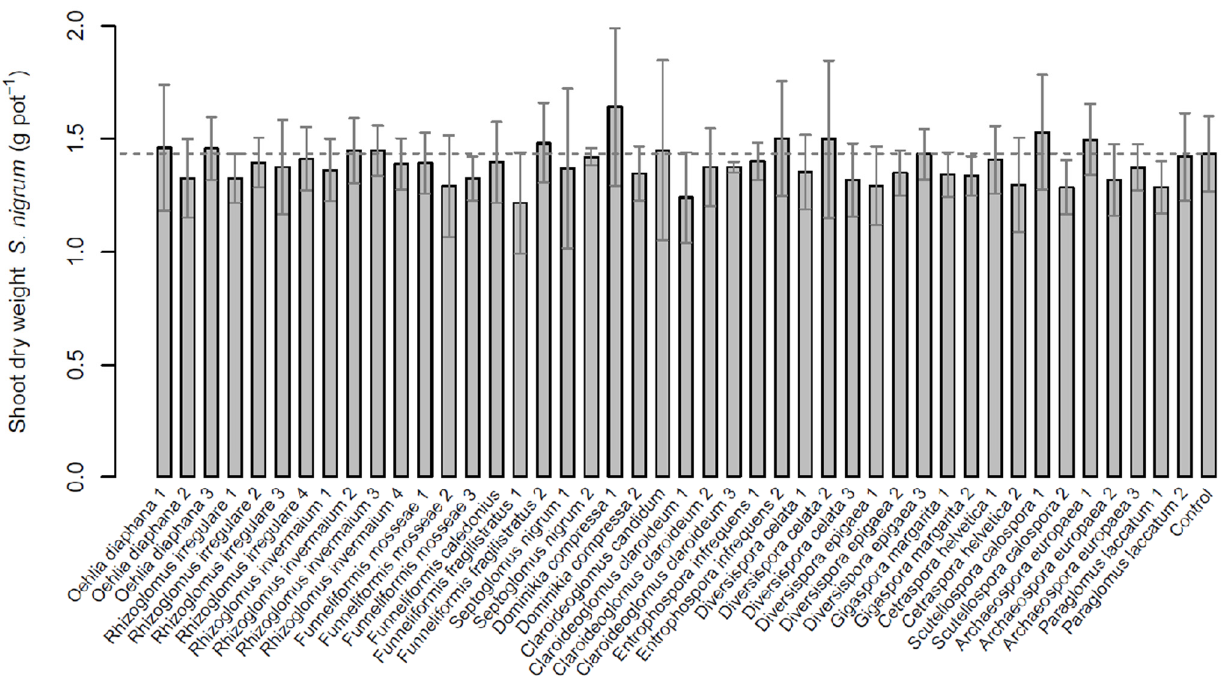
Figure 2. Aboveground dry mass of Solanum nigrum inoculated with 44 different isolates of arbuscular mycorrhizal fungi (AMF) and one non-mycorrhizal control. Data are reported as means (n = 6) and their standard deviations. No significant differences among AMF isolates or the control treatment were detected via Kruskal–Wallis test ( p < 0.05). Comparisons on the species level also could not detect significant differences ( χ 2 = 9.39, df = 18, p = 0.95). Mycorrhizal dependency was lowest for F. fragilistratus (F.fra1, − 22%) and highest for D. compressa (Do.com2, 10%; Table 2). However, there were no significant